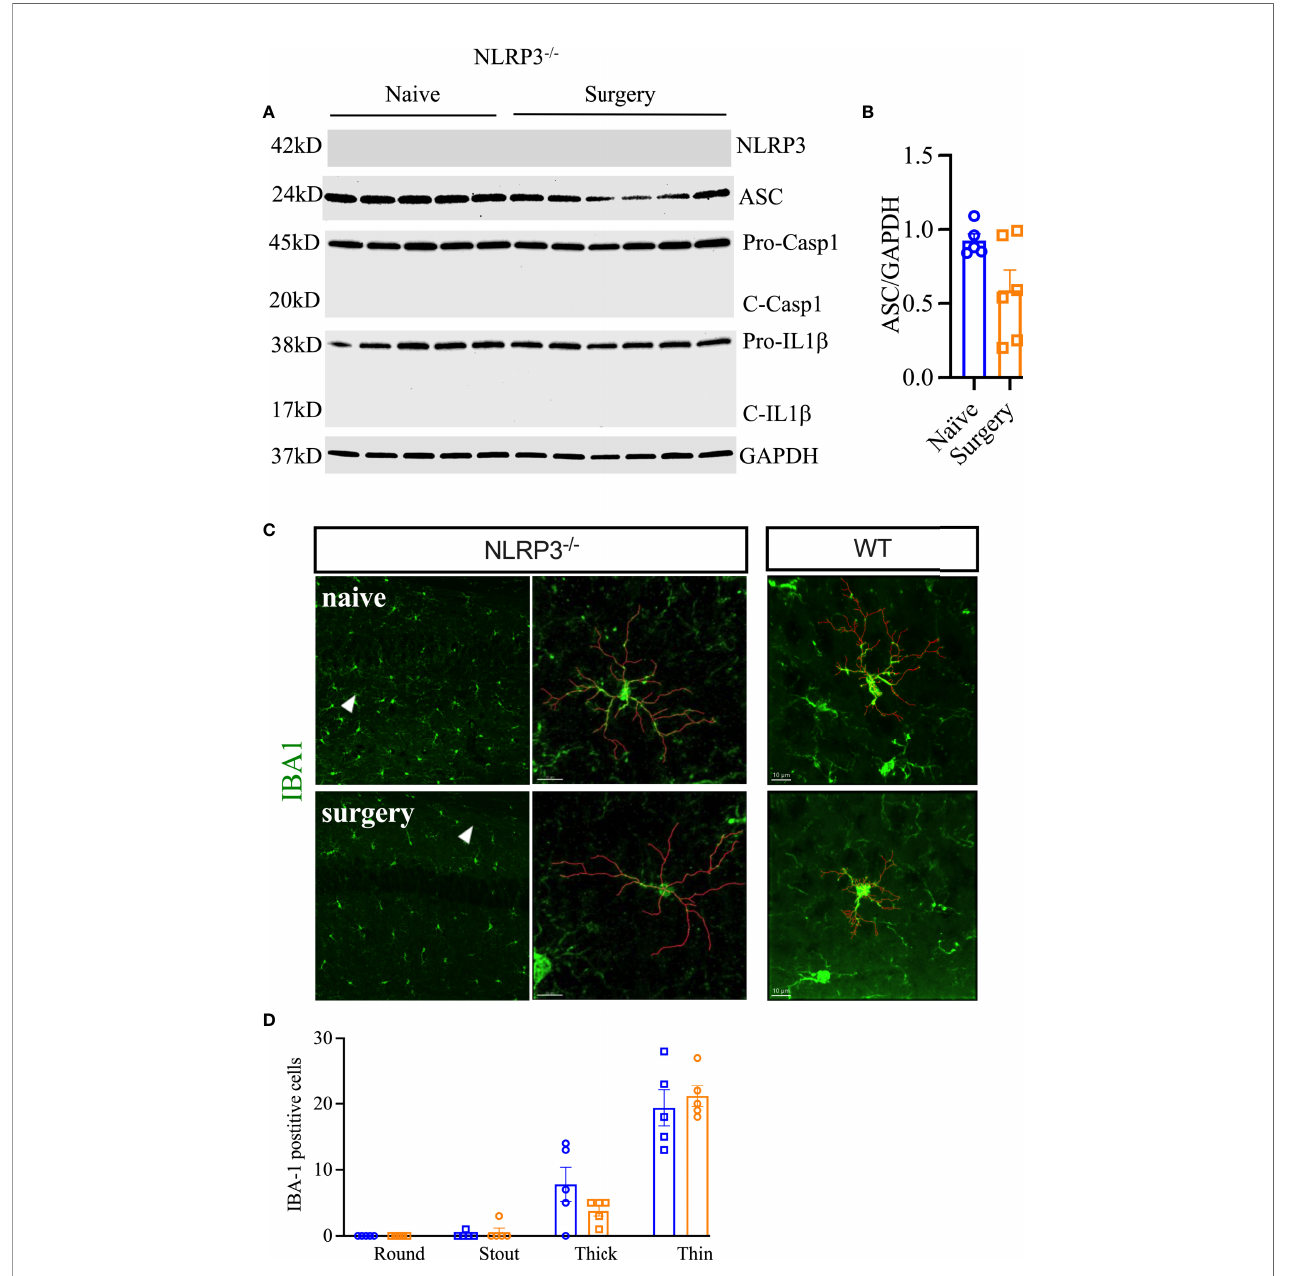
FIGURE 3 | Postoperative neuroin fl ammation in Nlrp3 -/- mice. The NLRP3 in fl ammasome was not activated in the hippocampus of these animals at 24 h post orthopedic surgery (A, B) . Moreover, no changes in microglial morphology were observed in Nlrp3 -/- mice after orthopedic surgery, as evidenced by IBA-1 immunostaining (C, D) . Microglial representative fi laments are provided from age matched C57BL6/J mice (WT) as comparison. For quantitation of WT data, refer to Figure 2B . Three representative areas/mice were used for quanti fi cation and one single microglia was represented in the reconstruction (red indicates fi lament tracing) from hippocampal CA1 area of Nlrp3 -/- mice only. Data are presented as mean ± SEM. n = 5-6/group. Scale bar: 20 m m. Representative data are from one